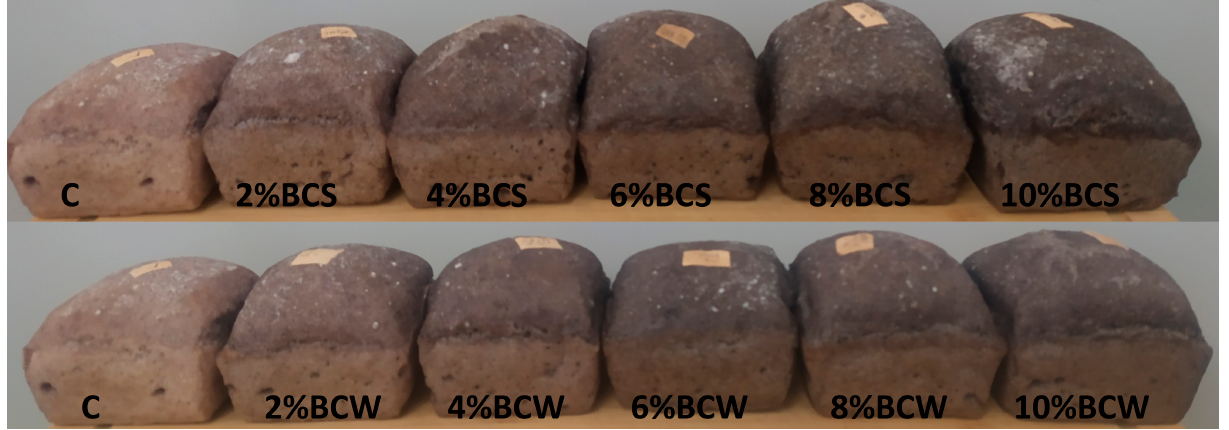
Figure 2. The external appearance of bread with different amounts of BCS and BCW: C—control starch bread, BCS—black cumin, BCW—black cumin pressing waste.